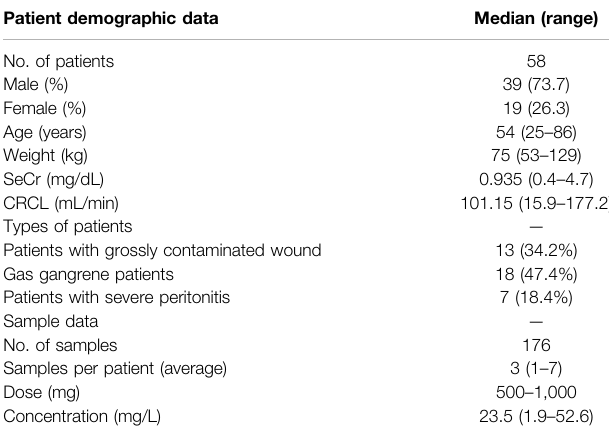
TABLE 1 | Patients and sample